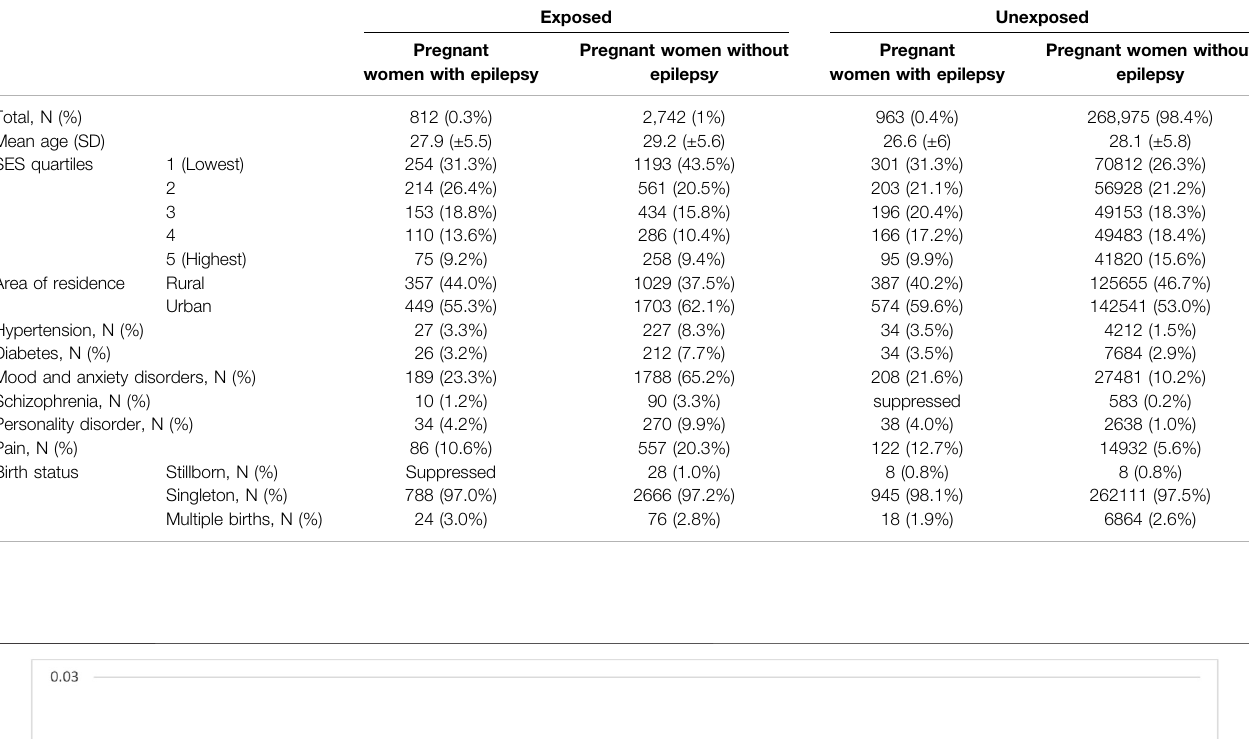
TABLE 1 | Characteristics of the study population by group.